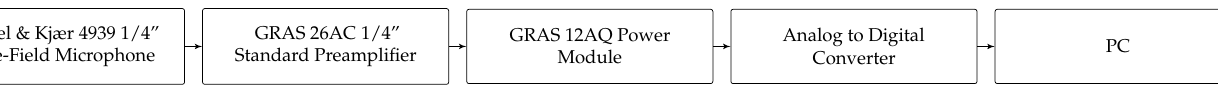
Figure 8. Block diagram of USPM that was used to characterize the sound field around worker’s